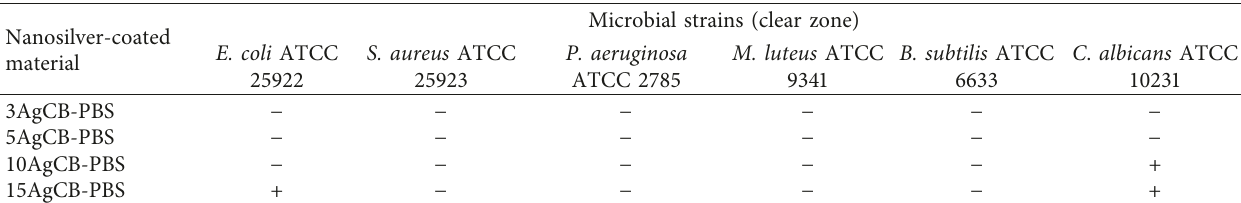
Figure 12: Positive tests for antimicrobial properties on E. coli and C. albicans using the agar disk diffusion method of (a) 3AgCB-PBS, (b) 5AgCB-PBS, (c) 10AgCB-PBS, and (d) 15AgCB-PBS composite Table 1: Antimicrobial properties of AgCB-PBS composite materials.